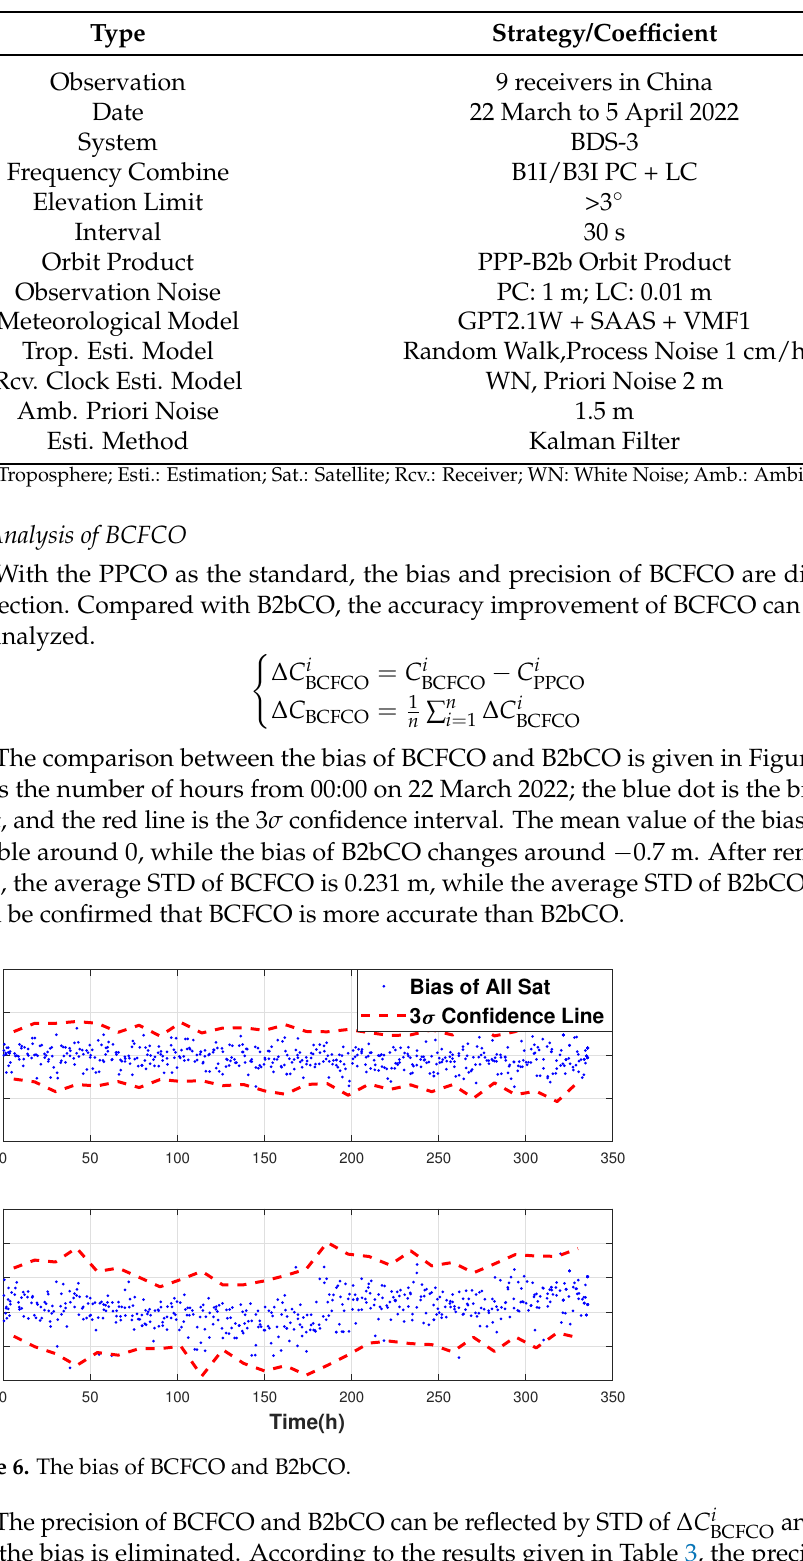
Table 2. Others coefficients and strategies of the filter.